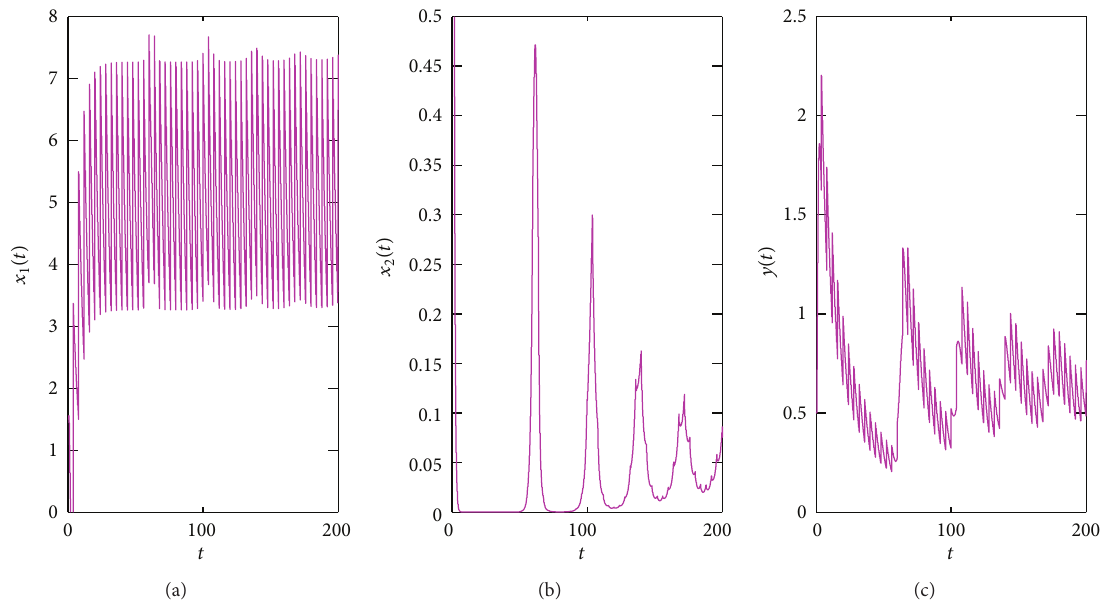
Figure 5: Time-series of the system (1) with pulse, where killing rate 𝑝 = 0.7 ; other parameters are the same as of those in Figure 4.